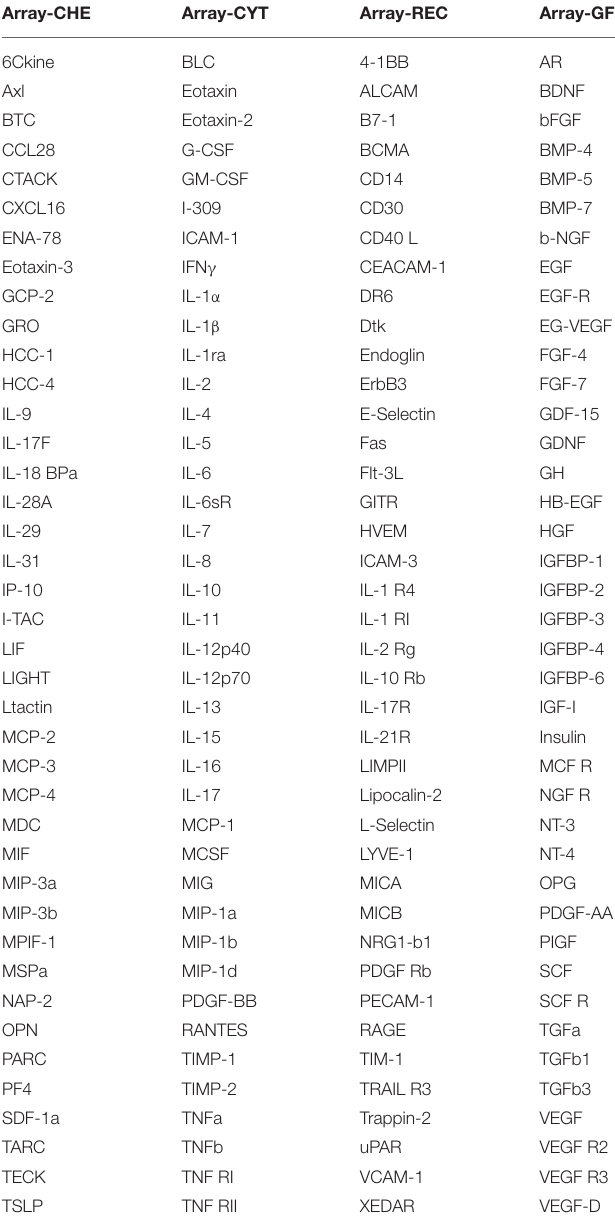
Abbreviations/Definitions: Supplemental Table